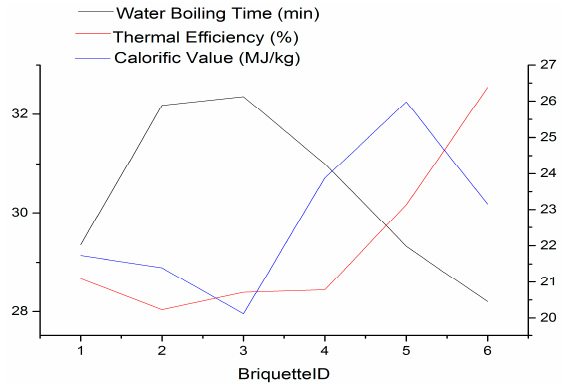
Figure 4. Plot of Calorific Value, Thermal efficiency and water boiling time.